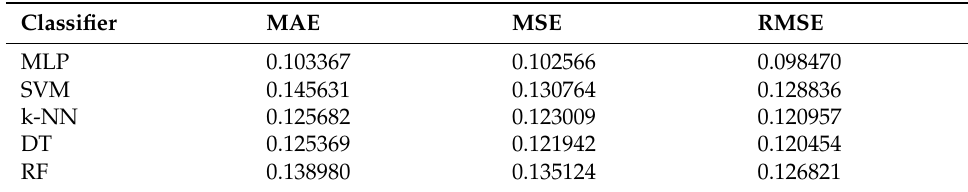
Table 4. The errors estimated for different predictive